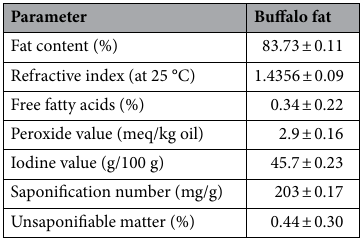
Table 1. Fat content (%) and some of its physicochemical properties. Data are expressed as mean ± SD values given represent means of three